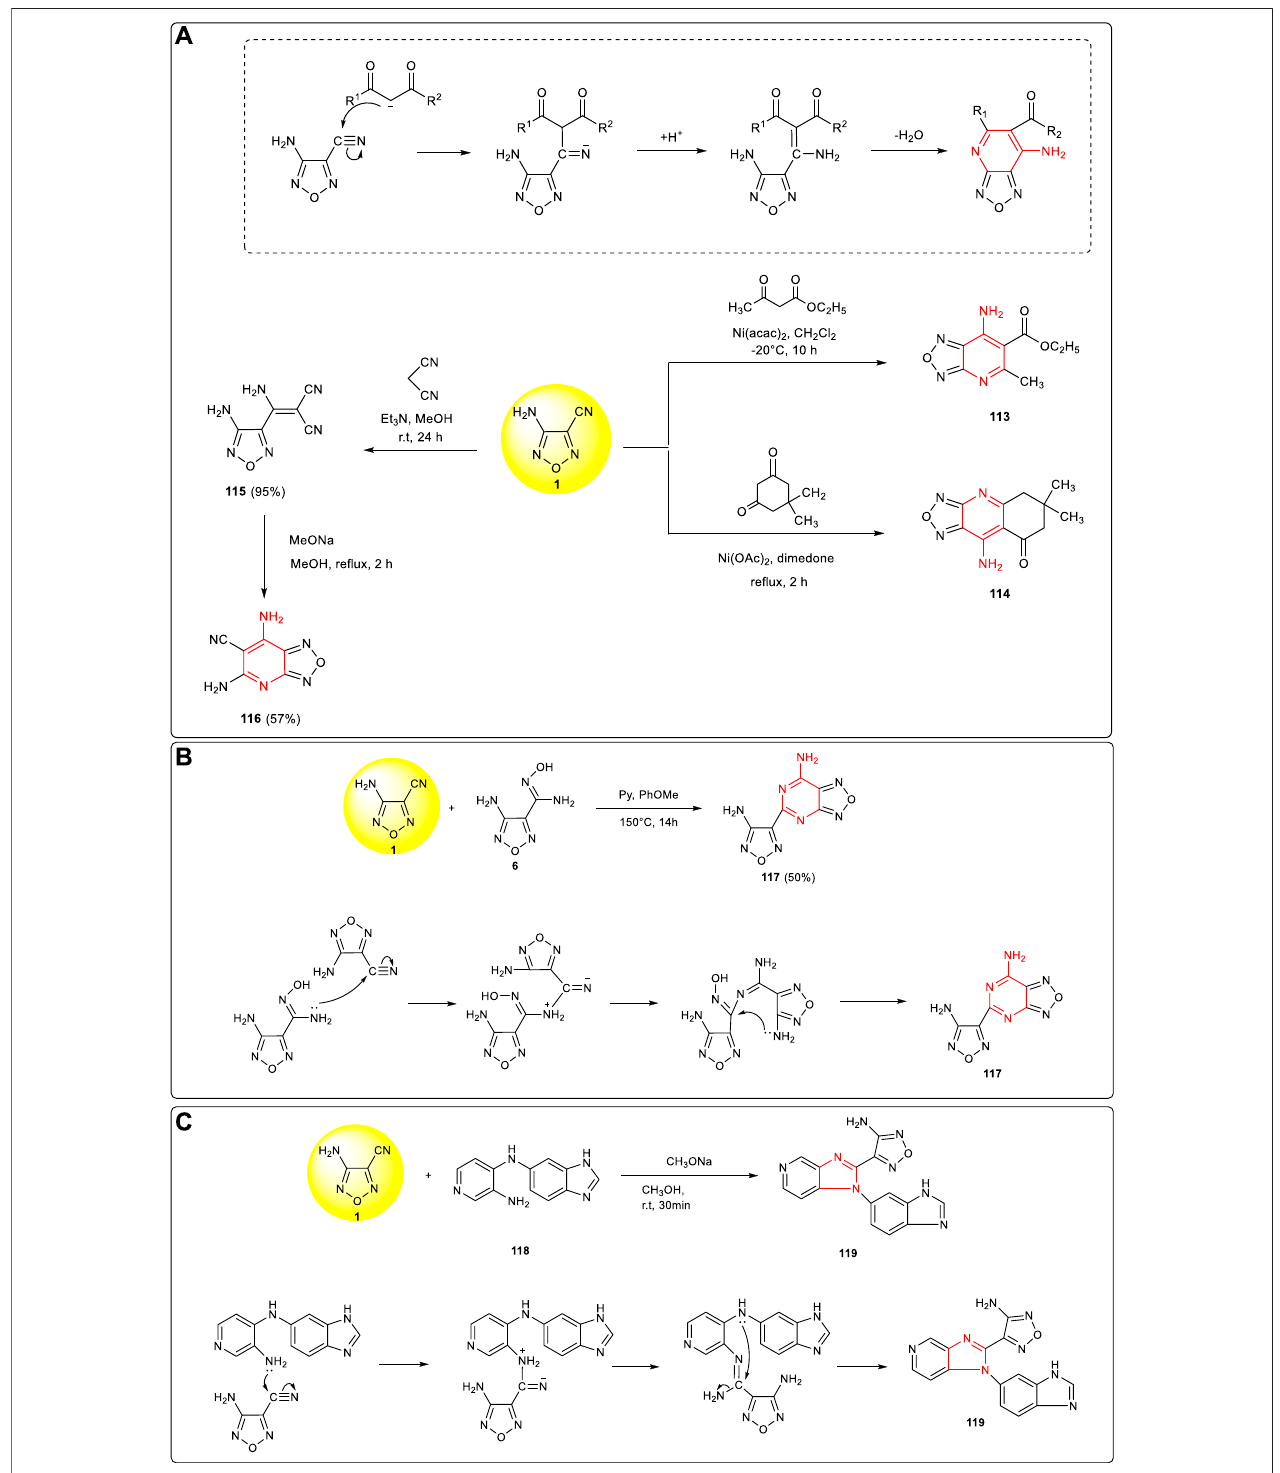
SCHEME 11 | (A) Cyclization mechanism of pyridofurazan and synthesis of pyridofurazan intermediates 113, 114, and 116; (B) synthesis of 117 and cyclization mechanism of the furazanopyrimidine framework; (C) synthesis of 119 and cyclization mechanism of the triazolofurazan framework.